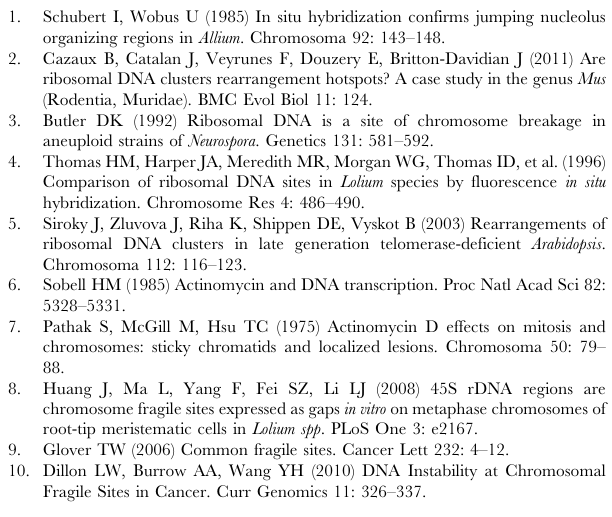
Figure S1 Effects of APH on centromeres and knobs in maize. (A) FISH mapping on metaphase chromosomes combined centromere probes (red) with 45S rDNA probes (green) showed that APH induced 45S rDNA lesions but had no effect on centromeres in the same metaphase spread after treatment with 15 m g/ml APH. Bar= 5 m m. (B) FISH image showed that decondensation of 45S rDNA was observed, but all of the centromeric sites remained intact blocks of heterochromatin in the same nucleus after treatment with 15 m g/ml APH. Bar= 10 m m. (C) FISH mapping combined knob probes (red) with 45S rDNA probes (green) showed that APH (15 m g/ml) induced NOR lesions but no visible damage on the knob regions in the same metaphase spread. Bar = 5 m m. (D) FISH image showed that extensive decondensation of 45S rDNA was observed, but all of the knob regions remained intact blocks of heterochromatin in the same nucleus after treatment with 15 m g/ml APH. Bar= 10 m m. Figure S2 Effects of ActD on centromeres and knobs in maize. ( A ) FISH image showed that all of the centromeric sites remained intact blocks of heterochromatin in both metaphase chromosome spread and interphase nucleus after treatment with 15 m g/ml ActD. Bar= 10 m m. (B) FISH image showed that all of the knob regions remained dense spots in both metaphase chromosome spread and interphase nucleus after treatment with 15 m g/ml ActD. Bar =10 m